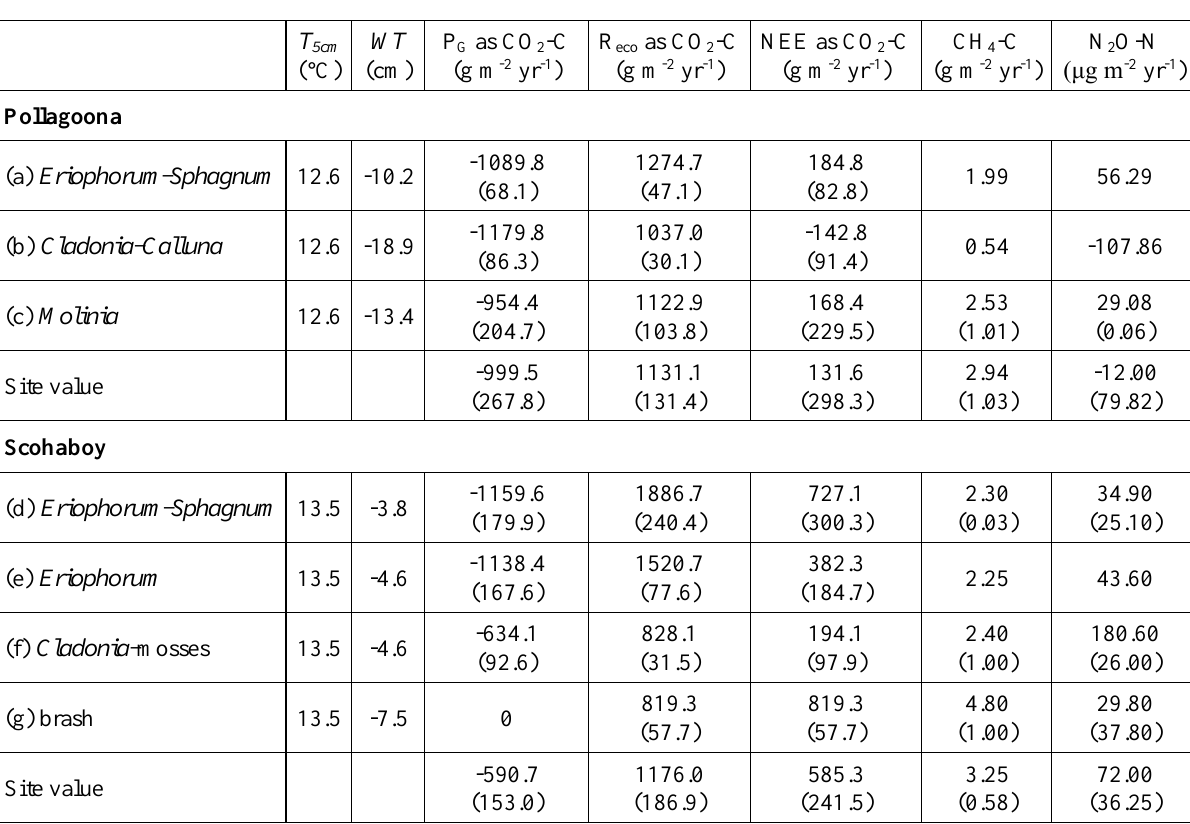
= soil temperature (°C) at 5 cm 5cm which was recorded continuously 5cm